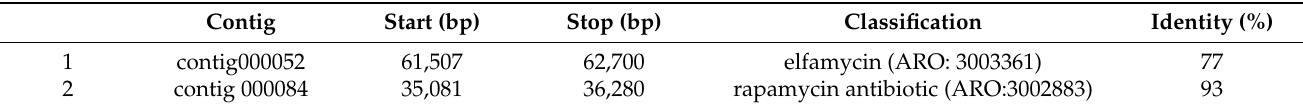
Table A2. Microtetraspora sp. AC03309 antibiotic resistant gene identified using CARD database. Contig